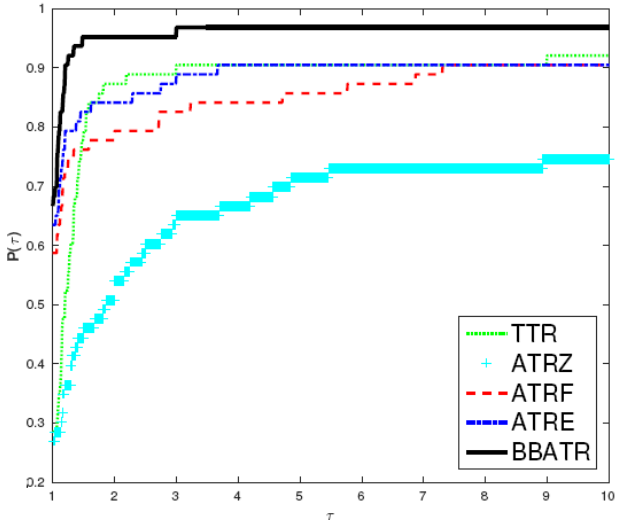
Figure 1. Iterates performance profile for the presented algorithms.